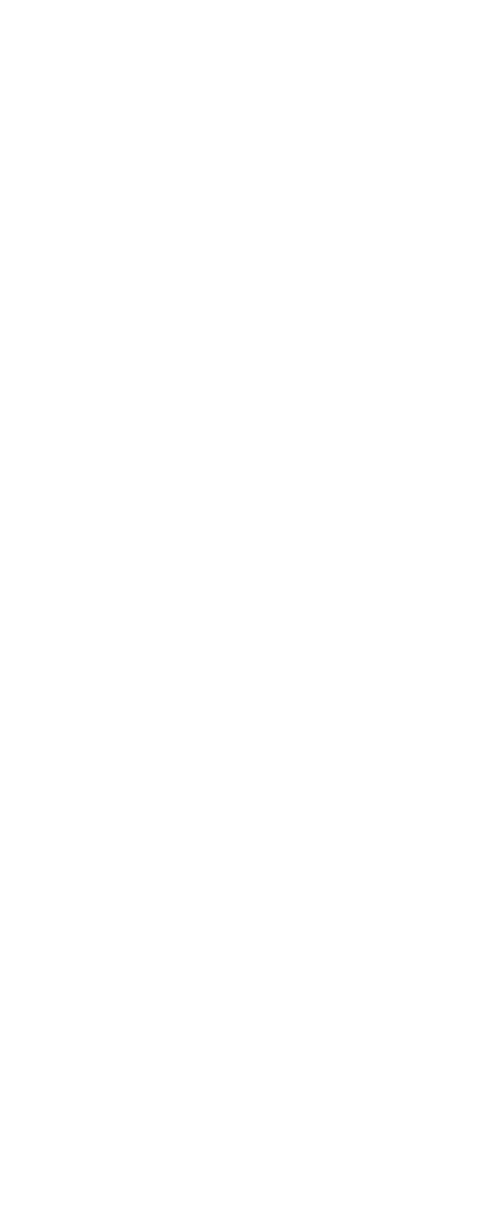
Figure 4. ( A ) Cladogram obtained from UPMGA estimation of twelve ALS full-length clone sequences, six of the S sample 16-1 (population 16S plant 1) and six of the R sample 45-4A (population 45R plant 4A), using MEGA X ® ; the mutation Trp574Leu was detected in all the sequences of the ALS1 of R samples; ( B ) cladogram obtained from UPMGA estimation of 79 ALS partial clone sequences starting from 3 (cid:48) -end belonging to the E. oryzicola populations 161S, 44R and 45R, using MEGA X ® . The corresponding sequences in ALS1 and ALS2 are highlighted in blue and orange, respectively. Sequences in blue of population 45R carry the mutation 574, other sequences mutated are present in ALS1 but are not highlighted to avoid